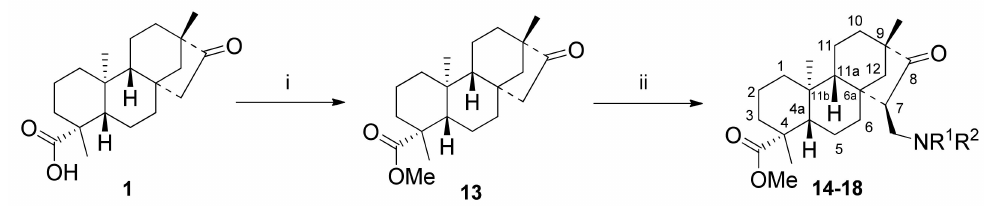
reaction took place in an exclusive stereoselective manner, forming a single diastereoisomer with (7 R ) configuration of the new stereocenter at C15. Results are collected in Table 2.